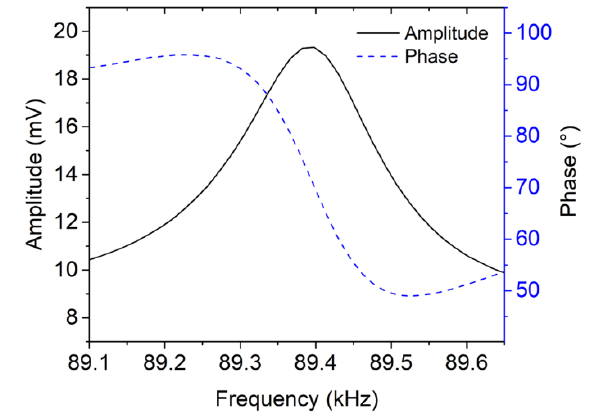
Figure 7. Frequency response of the AFM-MCS before particle exposure exhibiting a resonance frequency at ~89.38 kHz with phase and amplitude of ~72° and ~19 mV, respectively.